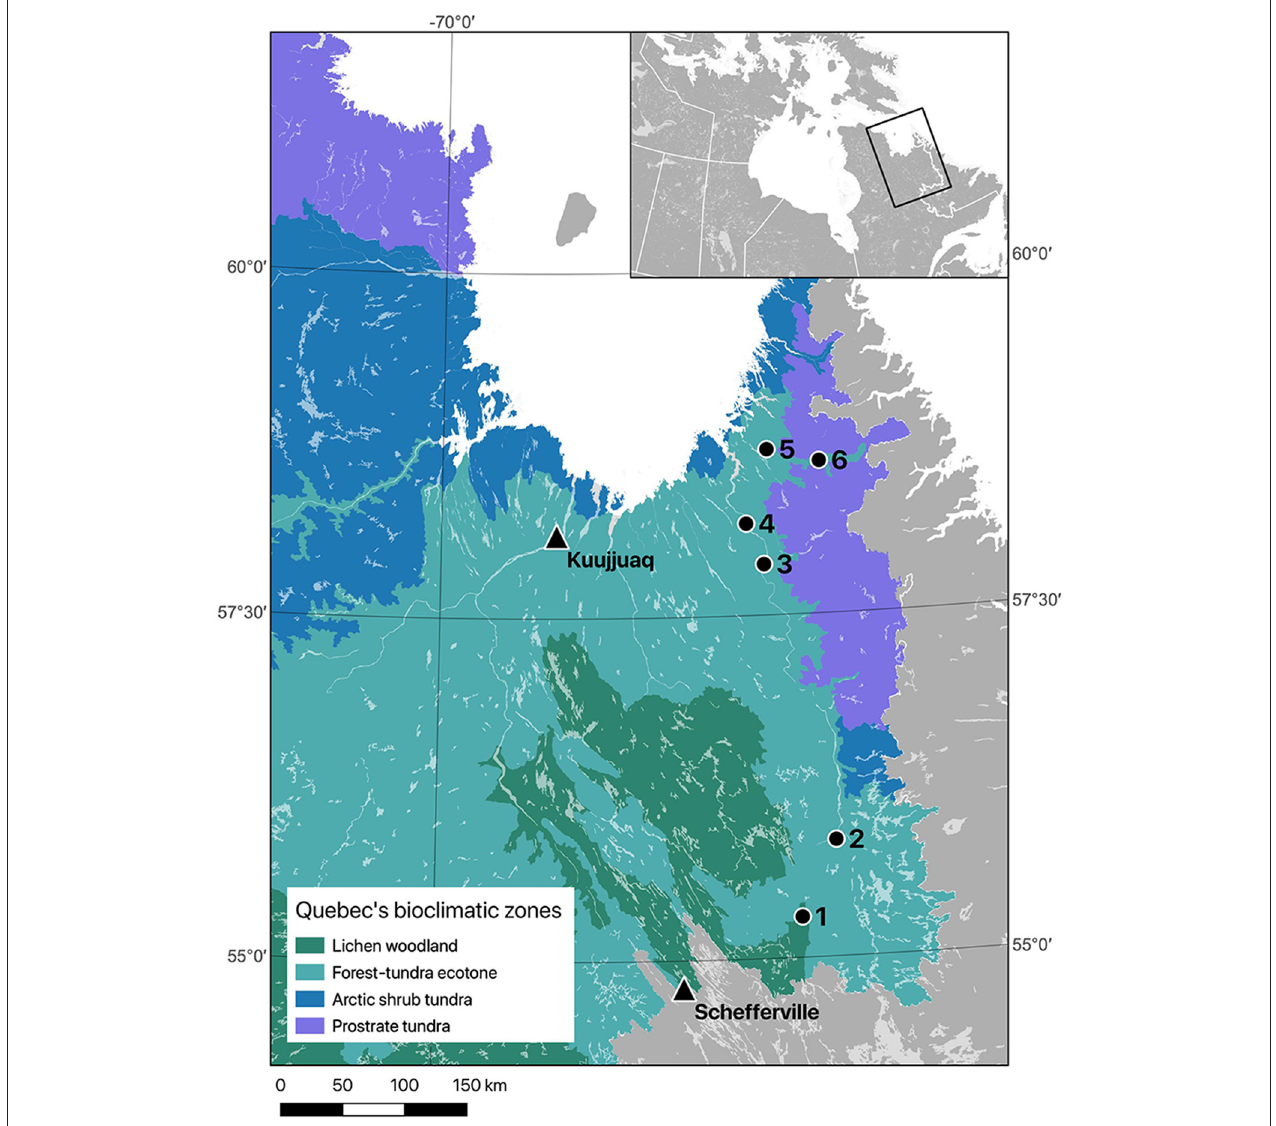
FIGURE 1 | Location of the six sites where black spruce wood disks were collected in 2018 (black dots, 1–6) in Nunavik (Québec, Canada), and the two weather stations from which daily temperatures were compiled for analyses (black triangles). Schefferville data were used for the southern region (sites 1 and 2), and Kuujjuaq data were used for the northern region (sites 3 to 6). Quebec’s bioclimatic zones follow the map produced by the Direction des inventaires forestiers (MFFP, unpublished).